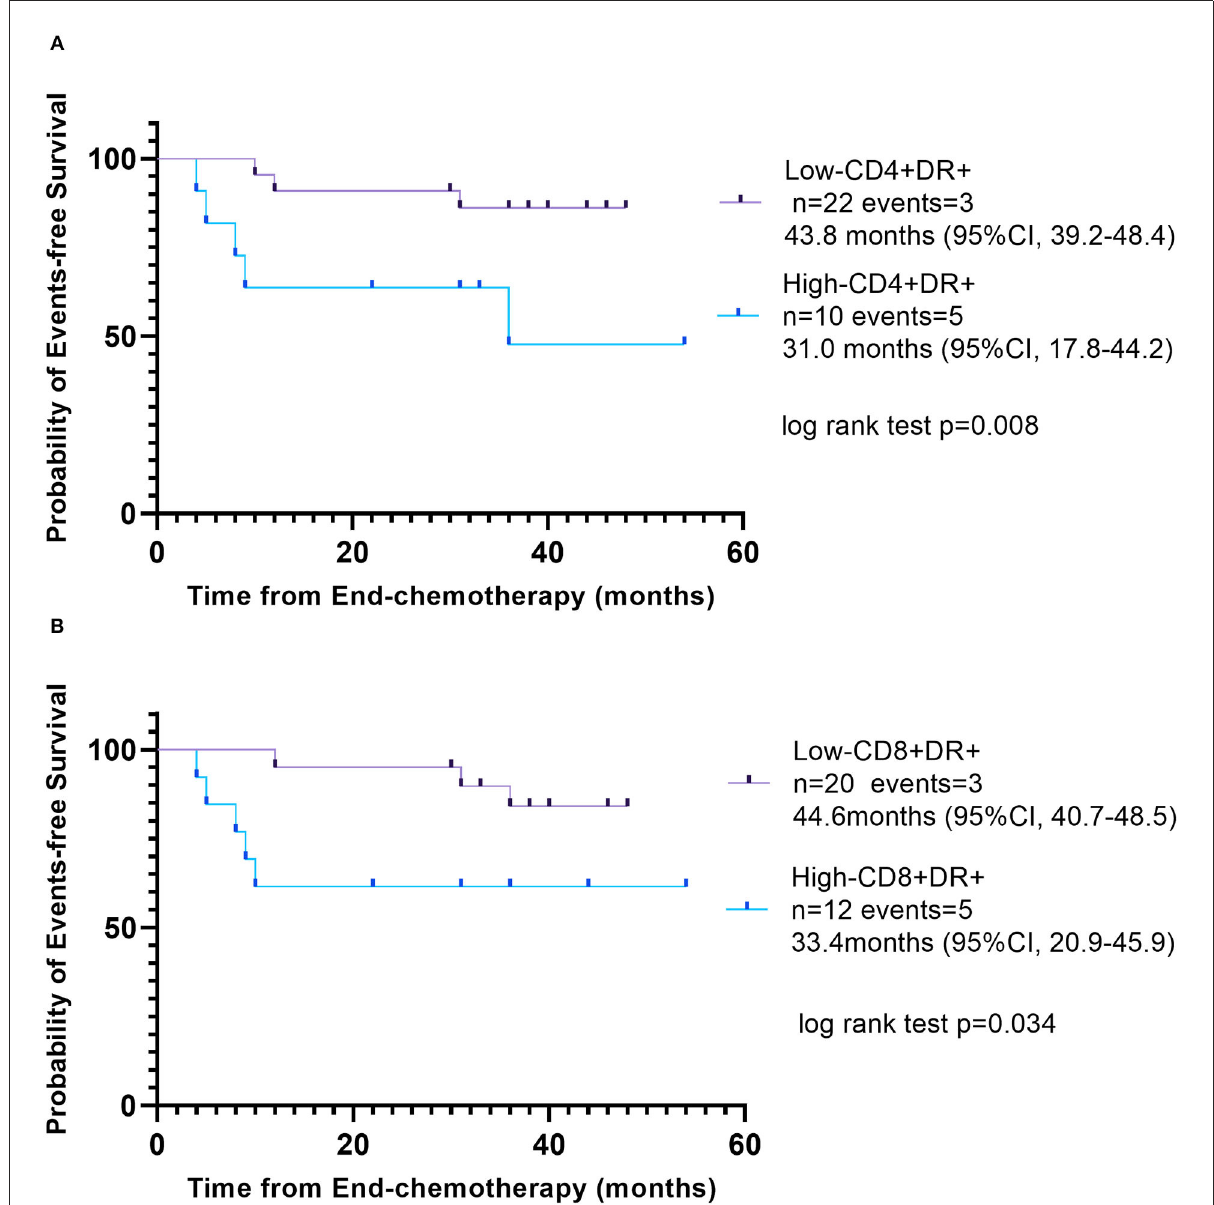
FIGURE4 Event-free survival according to different percentage of activated T cells. (A) Low CD3 + CD4 + HLA-DR + T cell (percentage ≤ 14.78%), purple line and high CD3 + CD4 + HLA-DR + T cell (percentage > 14.78%), blue line. (B) Low CD3 + CD8 + HLA-DR + T cell (percentage ≤ 43.15%), purple line; high CD3 + CD8 + HLA-DR + T cell (percentage > 43.15%), blue